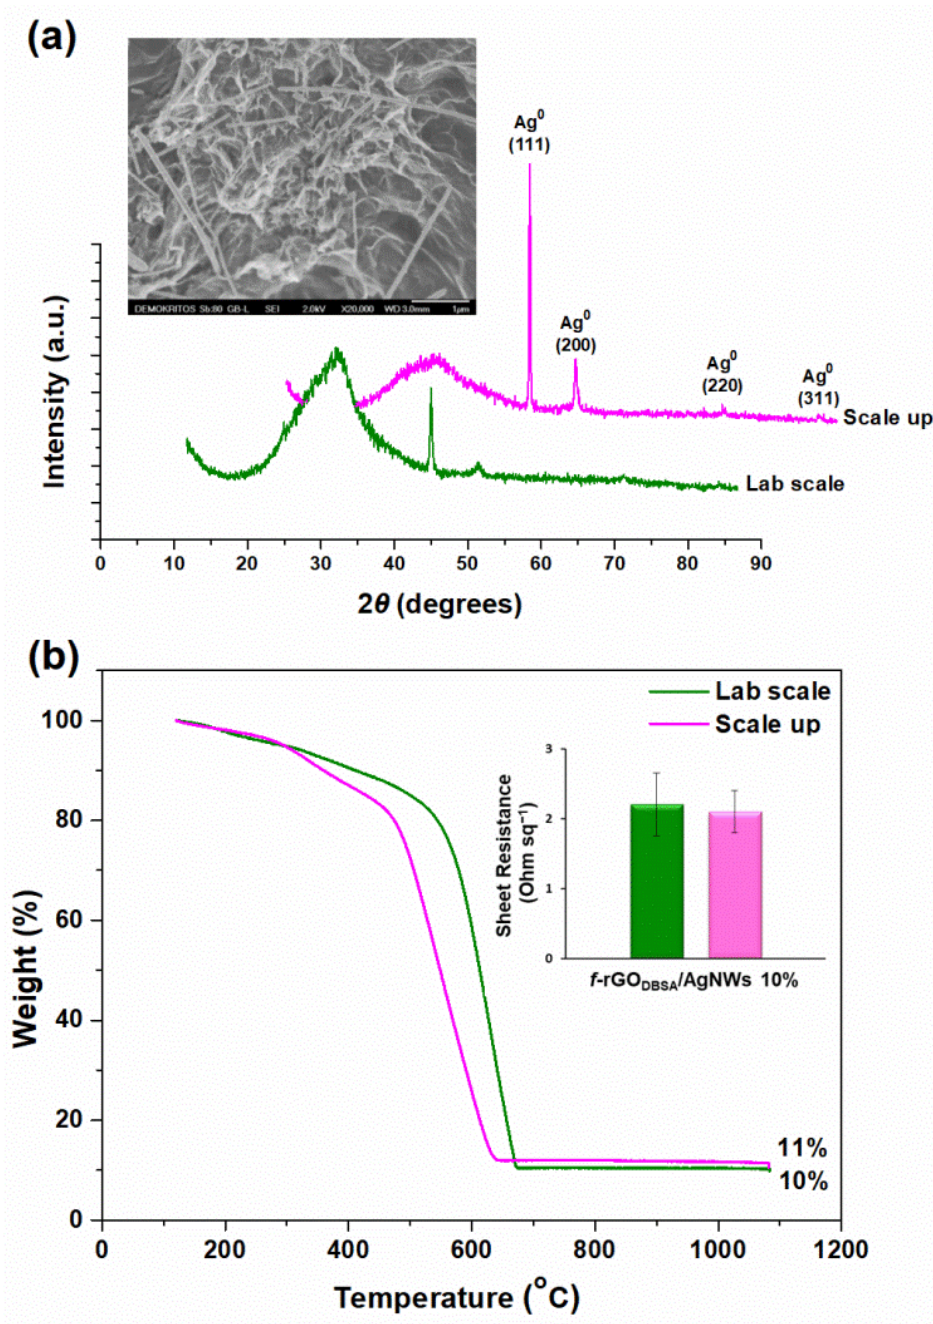
Figure 8. ( a ) XRD pattern of the up-scaled f -rGO DBSA /AgNWs10% hybrid in comparison with that of the lab-scaled hybrid (inset: SEM image of the scaled-up nanocomposite); ( b ) TGA curve for the up-scaled hybrid in comparison with that of the lab-scaled hybrid (inset: corresponding sheet resistance measurements).